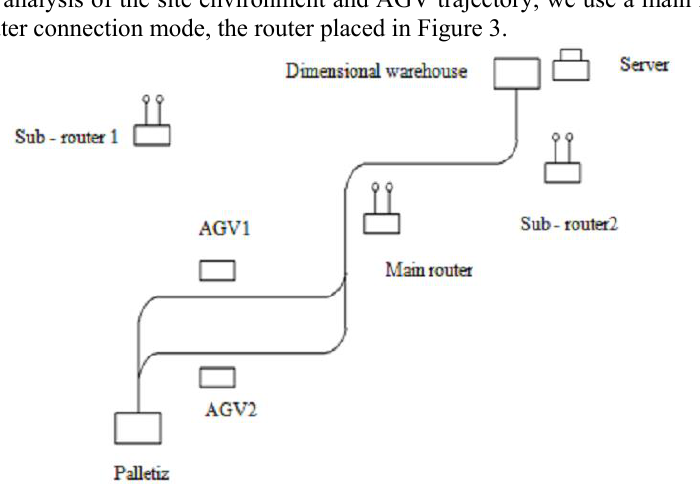
Fig. 3. Location map of